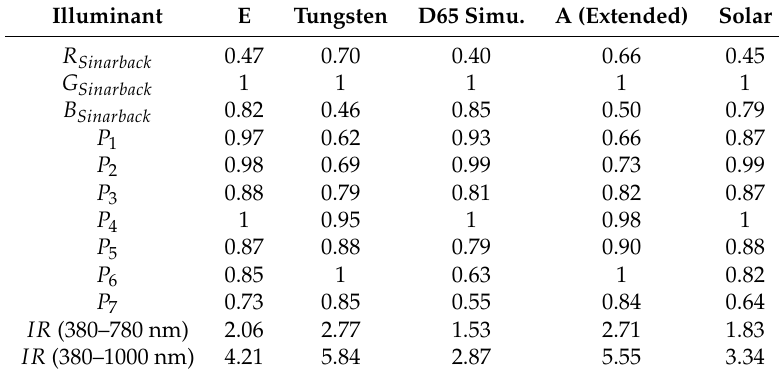
Table 3. Relative values of the sensor response by the filter ( ρ p ), for a given input illuminant ( I λ ) and a perfect diffuser. Illuminant E is extended to the NIR and the simulator of D65 used in image acquisition has been measured up to 1000 nm. All the illuminant emissions are visible in Figure 8.